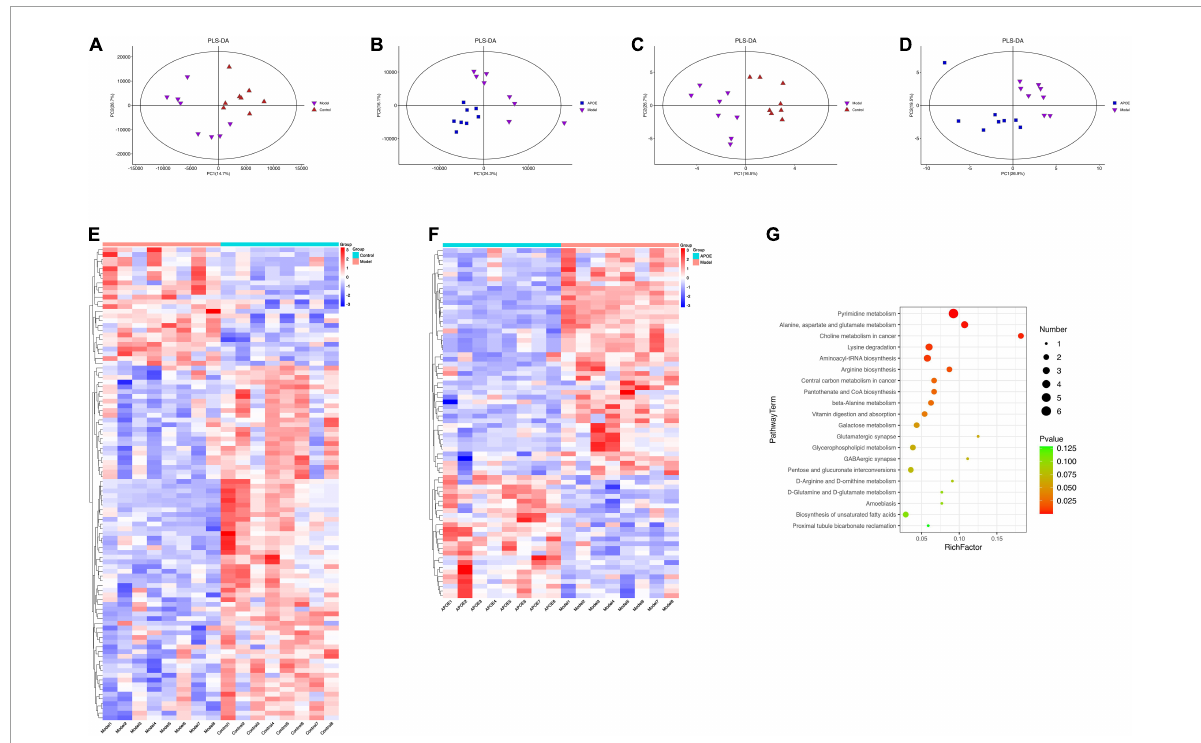
FIGURE6 Deletion of ApoE alters the metabolic profile of the hippocampus of aging mice. (A) PLS-DA of LC-MS about model group vs. control group. (B) PLS-DA of LC-MS about ApoE group vs. model group. (C) PLS-DA of GC-MS about model group vs. control group. (D) PLS-DA of GC-MS about ApoE group vs. model group. (E) Differentially abundant metabolites about model group vs. control group. (F) Differentially abundant metabolites about ApoE group vs. model group. (G) Analysis of metabolic pathway